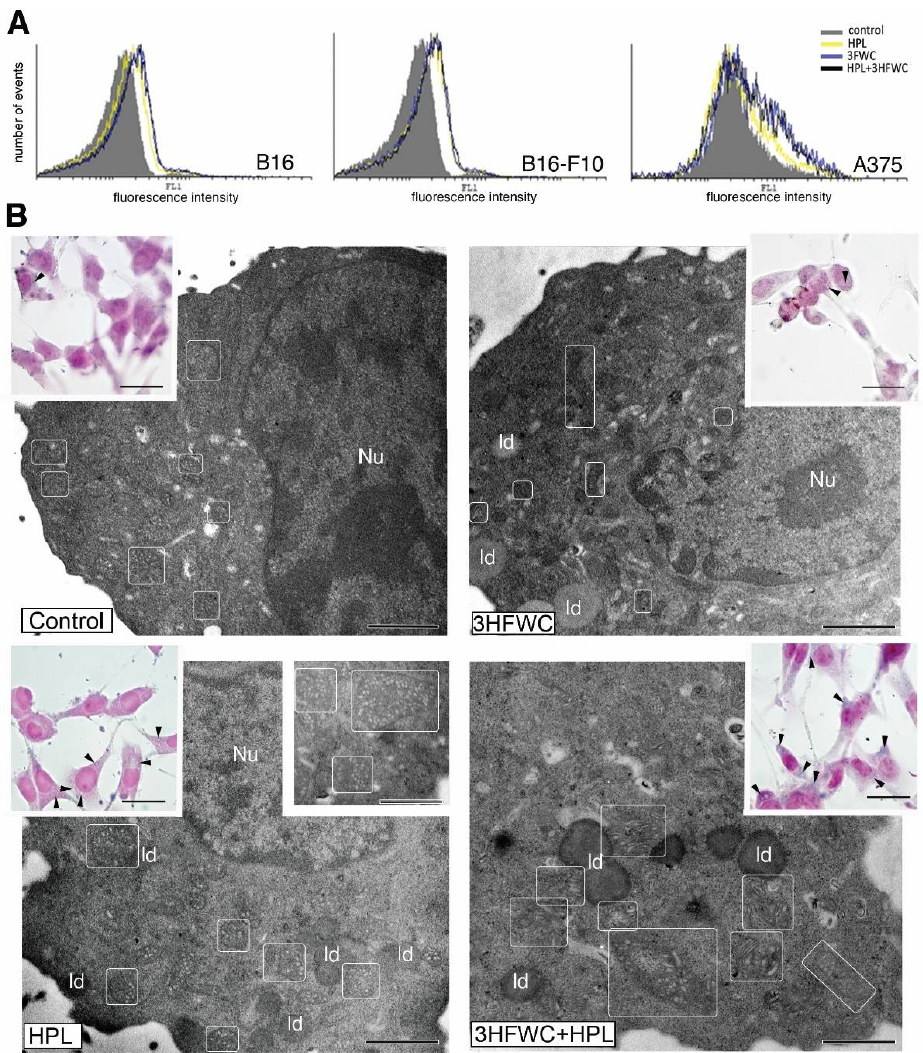
Figure 4. Cell senescence stimulation by 3HFWC and/or HPL. ( A ) Senescence-associated β-galactosidase detection; ( B ) microscopic analysis of senescent phenotype; TEM analysis of B16-F10 cells (Nu—nucleus; ld—lipid droplet; in rectangles—mitochondria) and Sudan black B staining of lipid droplets (inserts, black arrowheads); magnification and scale bar: TEM: ×13,000, 1 µm; LM: ×1000, 20 µm.